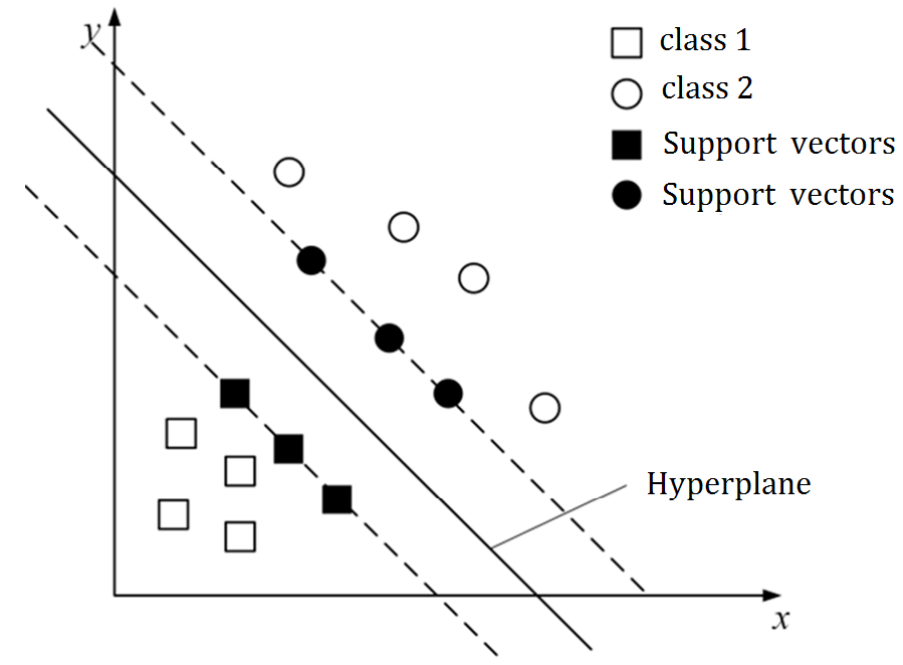
Figure 8. Principle diagram of SVM.